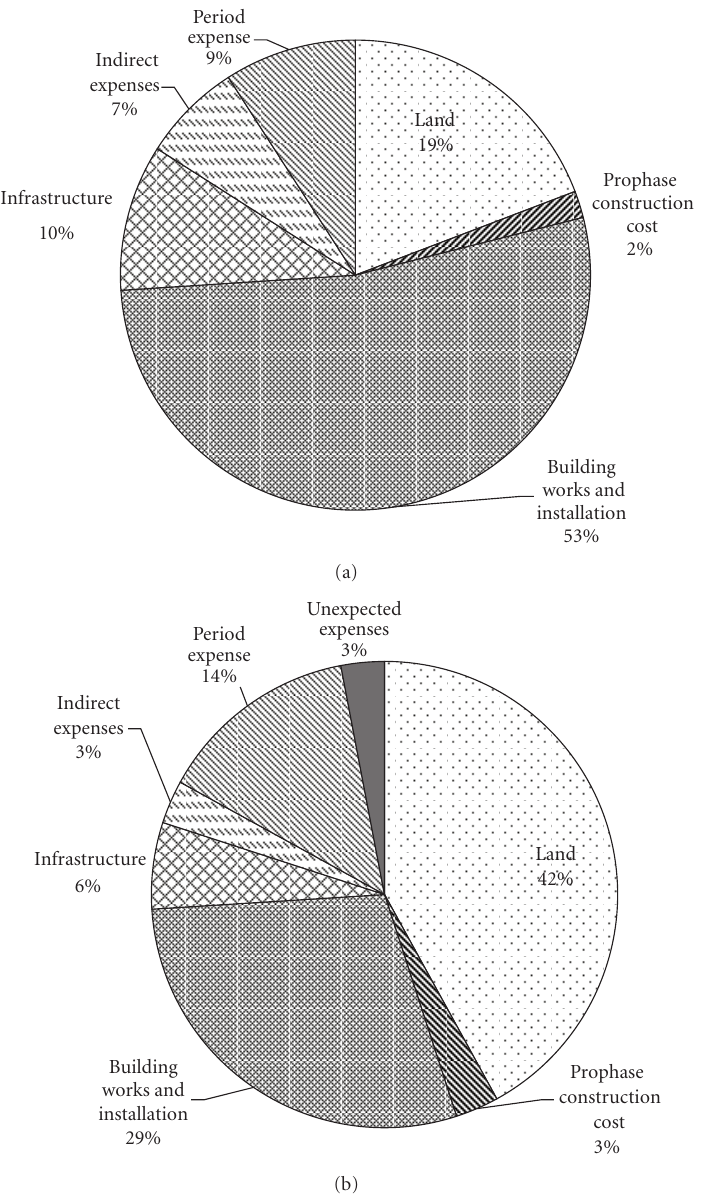
Figure 5: Investment structure of the LCHE industrial park and the average real estate investment in China ((a) LCHE industrial park, (b) the average